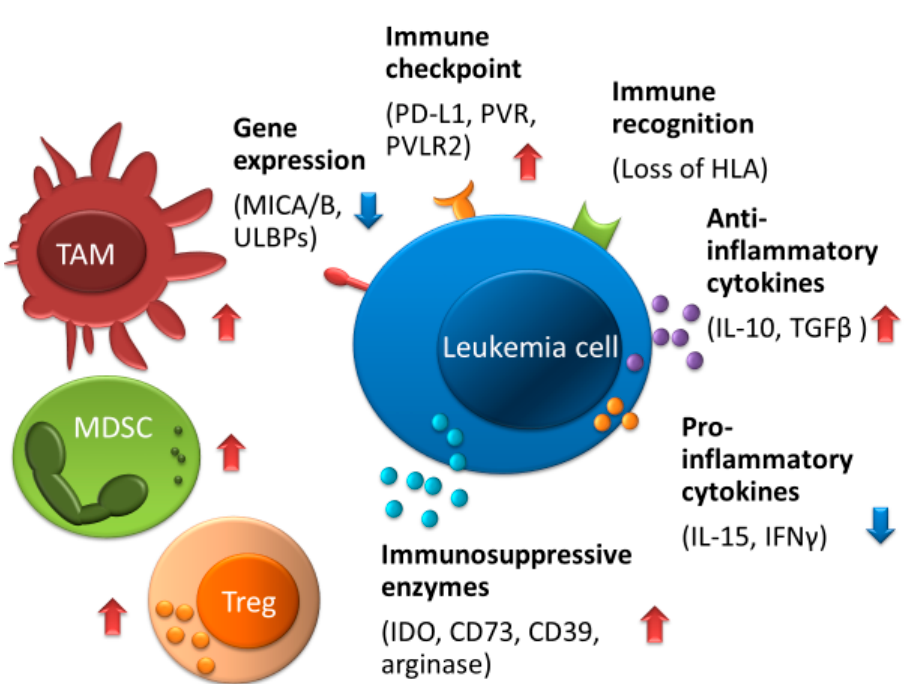
Figure 3. Mechanisms of immune escape against NK cells in AML. The tumor microenvironment consisted of Tregs, TAMs, and MDSCs which can interfere with the function of NK cells, and its microenvironment is increased by anti-inflammatory cytokine including TGF- β , IL-4, and IL-10 and is decreased by pro-inflammatory cytokines including IFN- γ and IL-15. Leukemia cells can produce the metabolic enzymes such as IDO, arginase, CD39, and CD73, which reduce NK cell activity. Upregulation of immune checkpoint molecules including PD-L1, PVR, and PVLR2, low expression of NKG2D ligands such as MICA / B and ULBPs, or impaired expression of HLA can contribute to evading immune surveillance by NK cells. Abbreviations: TAM, tumor-associated macrophages; MDSCs, myeloid-derived suppressor cells; Tregs, regulatory T-cells. Red arrows indicate increased expression, enzymes, cytokine production, and cell proliferation; blue arrows indicate decreased expression and cytokine production.